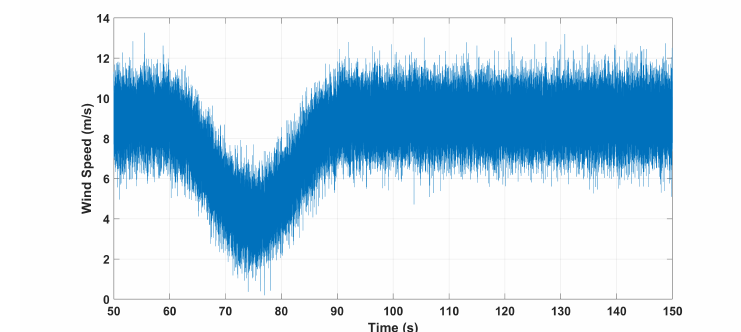
Figure 7. Wind turbulence and wind gust.